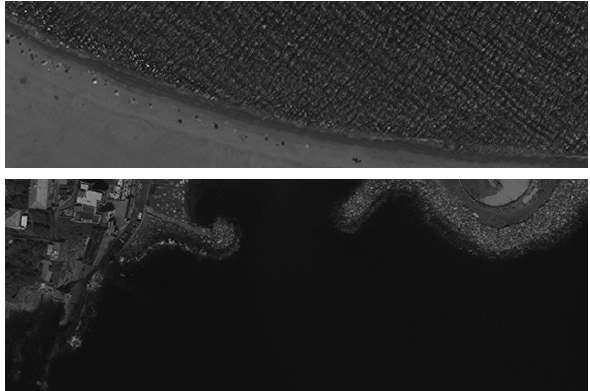
Figure 5: Regions for negative training